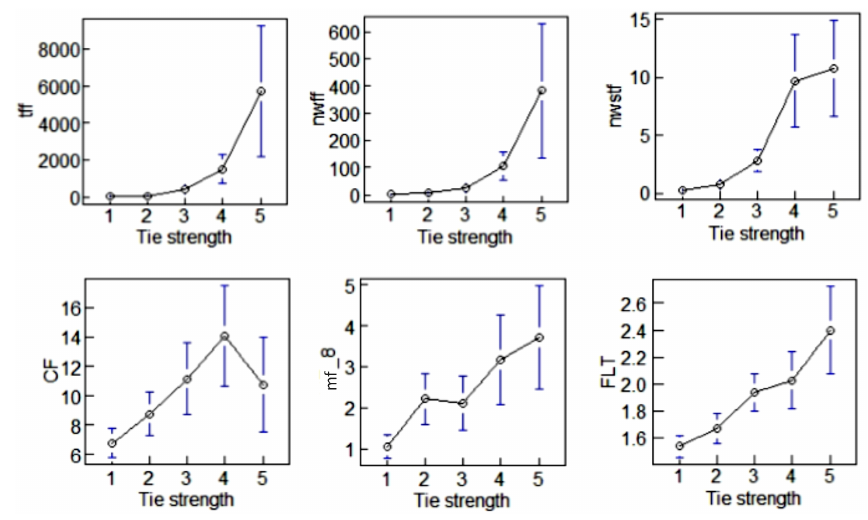
Fig. 3 Mean and variance of significant factors in five types of